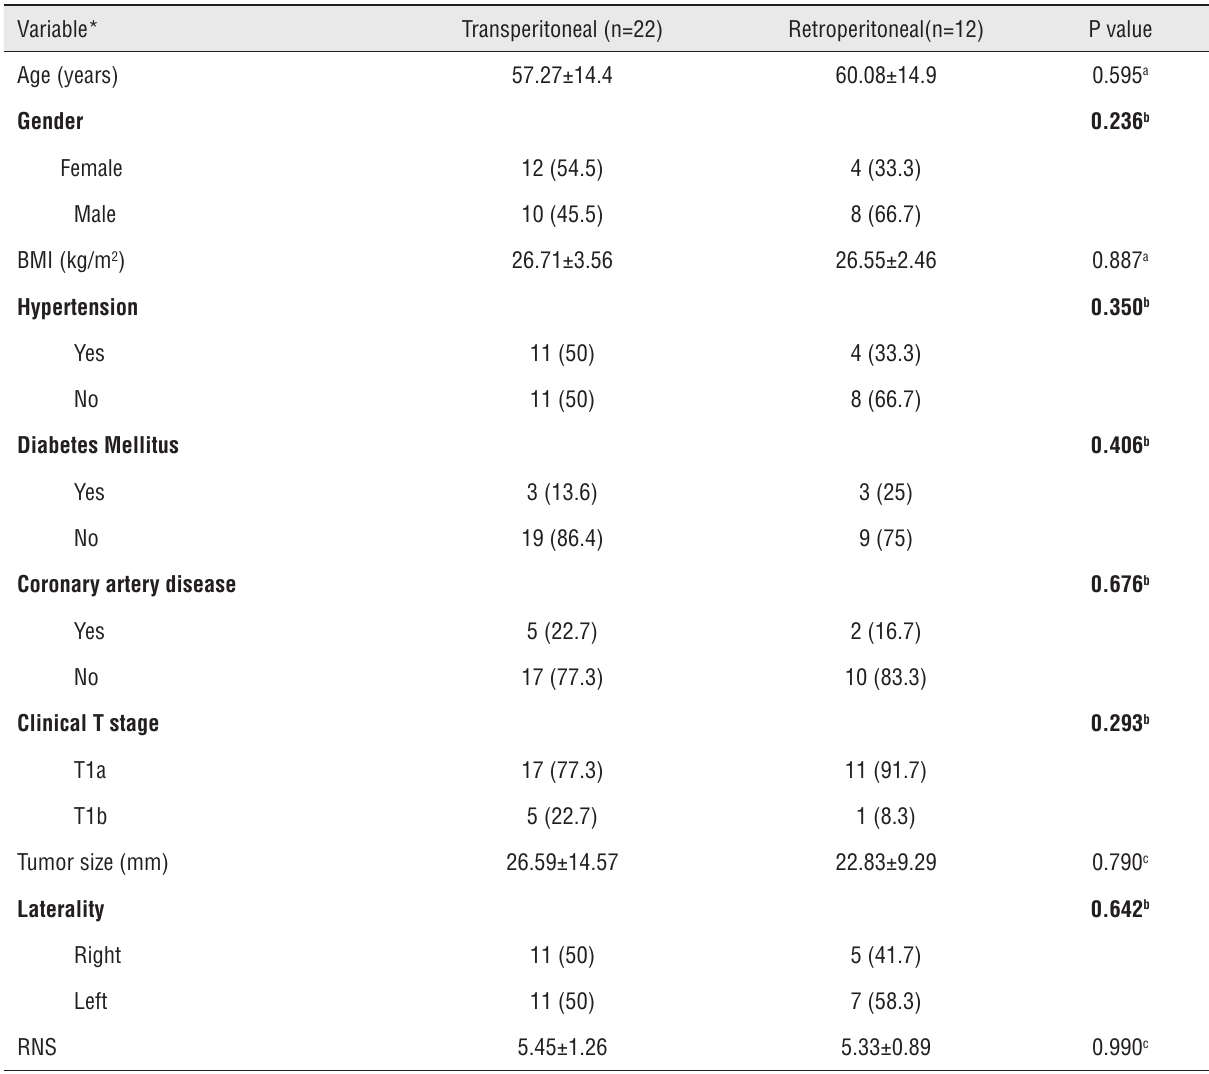
Table 1 - Demographics Features and Clinical Tumor